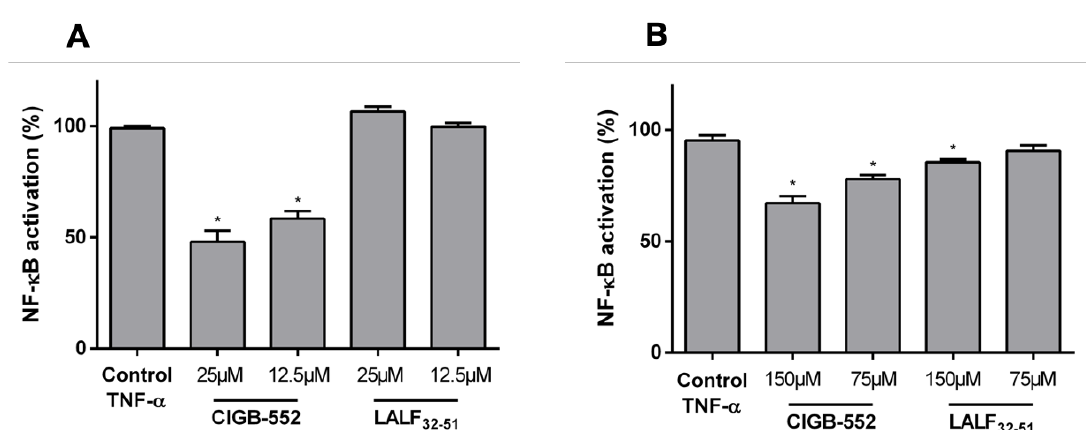
Figure 1. Evaluation of TNF- α -induced NF- κ B activation in reporter cell lines treated with CIGB-552 or LALF 32 – 51 . H460-NF- κ B-hrGFP ( A ) and HT-29-NF- κ B-hrGFP ( B ) were treated with the peptides and TNF- α for 24 and 48 h, respectively, and GFP expression was assessed by flow cytometry considering 10,000 single cells for each sample. NF- κ B activation was calculated considering GFP expression of the TNF- α -stimulated control as 100% activation and data were normalized to this 100% con- trol. Data represented as the mean SD of technical triplicates of one representative experiment out of three. One-way ANOVA analysis (Dunnett’s post -test) was applied to compare the treated groups with the control condition, * p < 0.05.